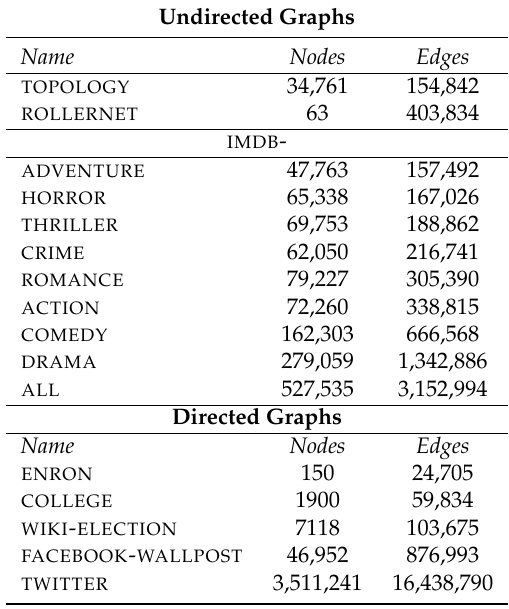
Table 2. Number of nodes and edges of each (undirected or directed) graph. Undirected